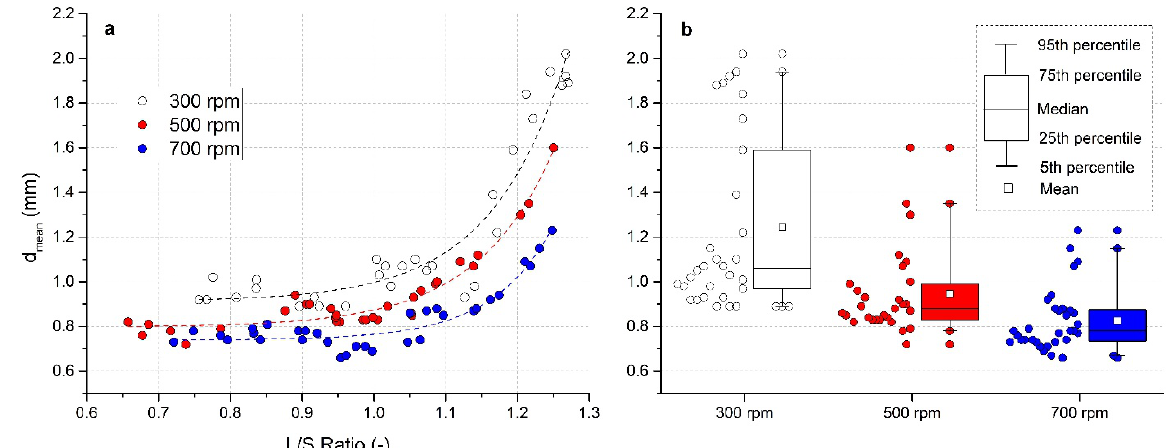
Figure 4. Evaluation of mean granule size for impeller speeds 300, 500, and 700 rpm: ( a ) effect of the L/S ratio on mean size d mean , ( b ) box charts of d mean for different impeller speeds. The picture shows a description of box charts.